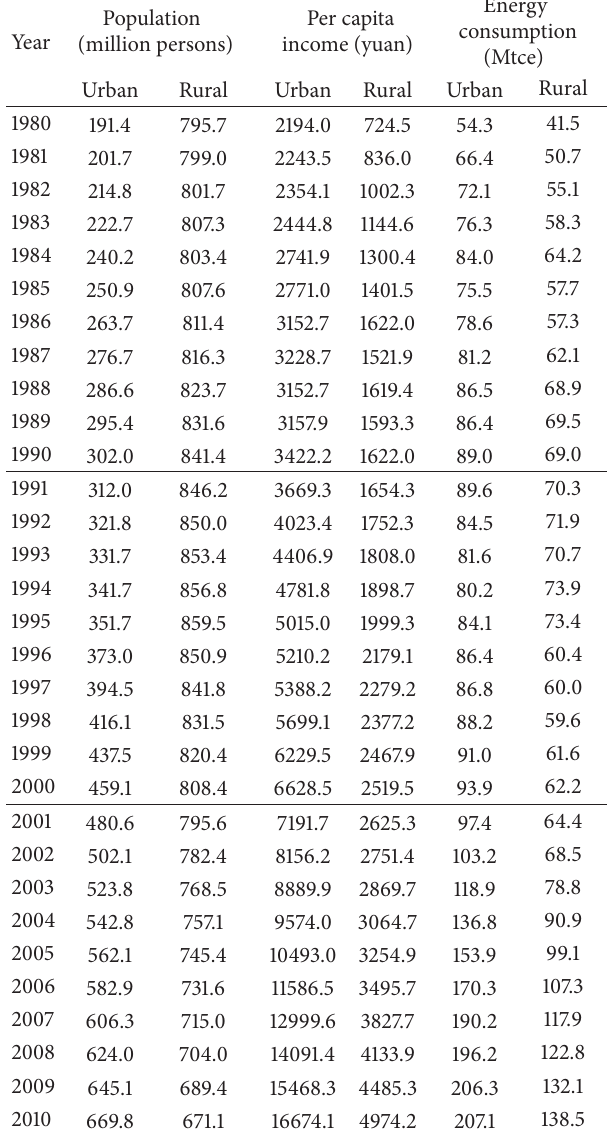
Table 2: China’s population, annual per capita income, and energy consumption by residence.